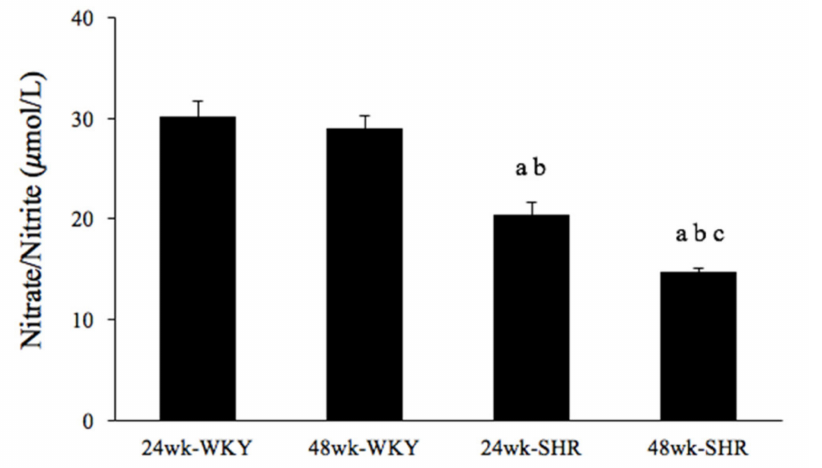
Figure 4. Serum nitrate/nitrite concentration in the 24wk-WKY, 48wk-WKY, 24wk-SHR, and 48wk- SHR groups. a p < 0.05, significant differences from 24wk-WKY; b p < 0.05, significant differences from 48wk-WKY; c p < 0.05, significant differences from 24wk-SHR; n = 8 in each